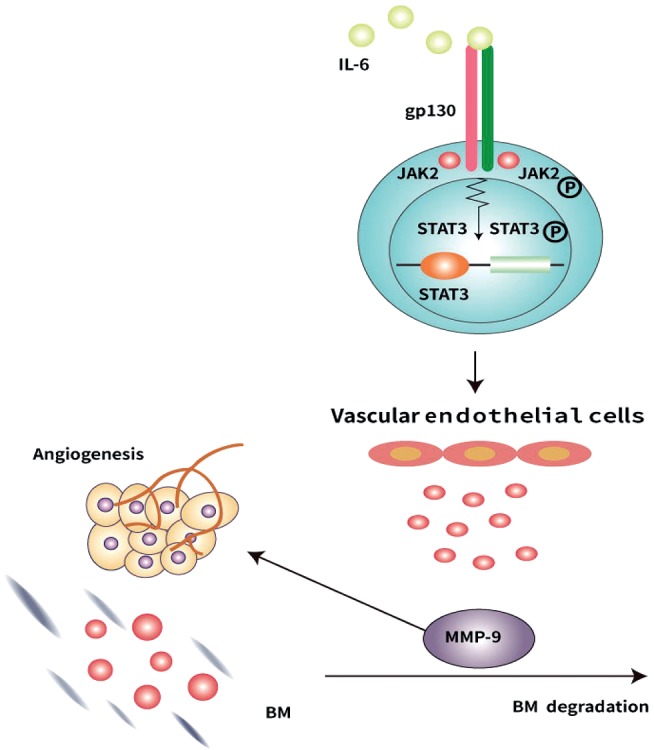
The role of the IL-6/JAK2/STAT3/MMP-9 pathway in the regulation of hypoxia-mediated microvessel proliferation and basal membrane degradation. Under hypoxic conditions, the increased IL-6 binds to IL-6 receptor α and activates gp130 to induce JAK2 phosphorylation. P-JAK2 upregulates MMP-9 secretion in the vascular endothelial cells leading to microvessel proliferation and basal membrane degradation.